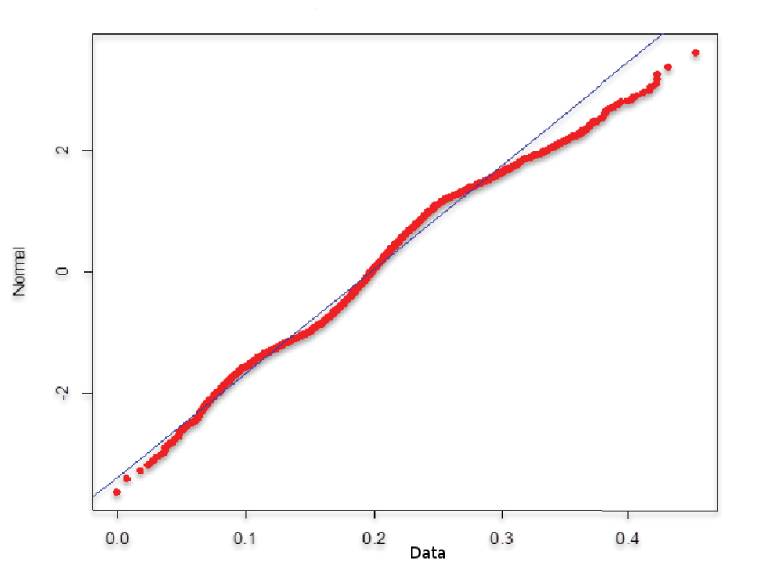
Fig 7. Shapiro-Wilk Normality Test stock rate of return (different types of agents with confidence). Source: Own creation.